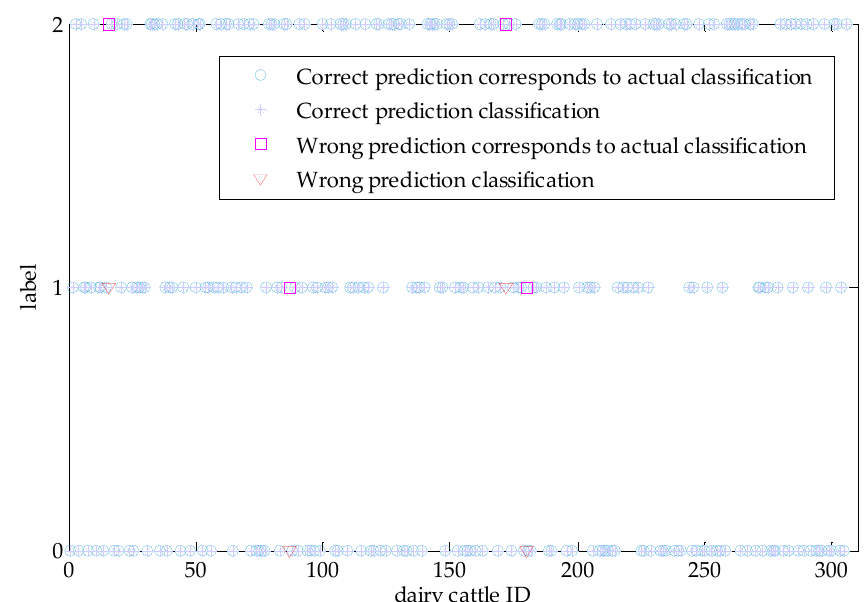
Figure 10. Actual and predicted classification diagram for the test set.